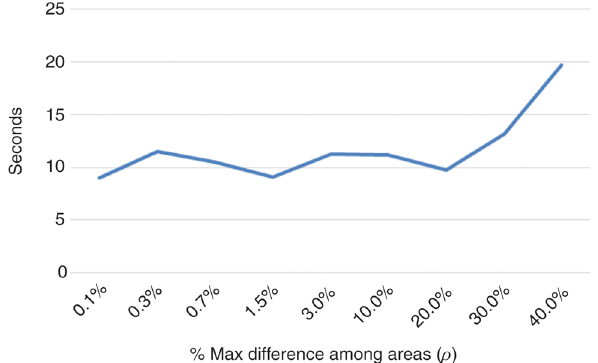
Figure 6: Total time with respect to ρ .